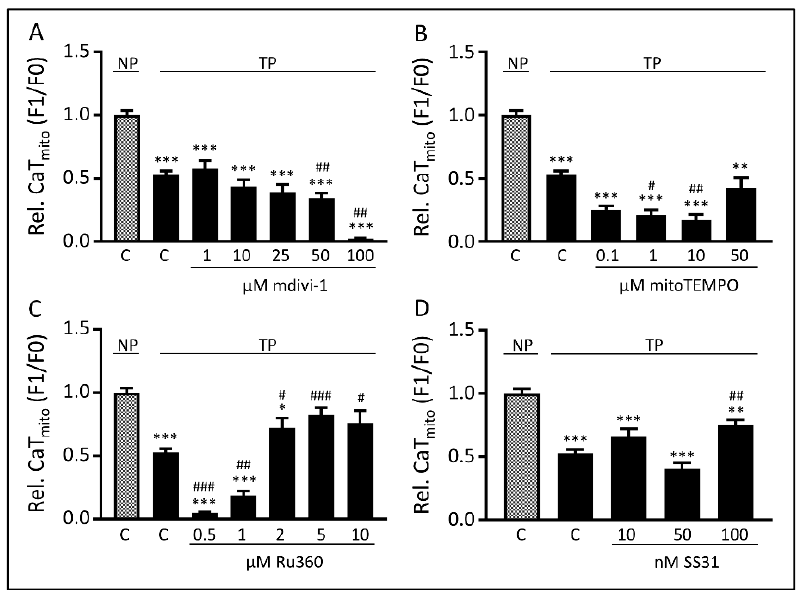
Figure 3. Ru360 and SS31, but not mdivi-1 or mitoTEMPO protect against tachypacing-induced CaT mito amplitude loss. CaT mito amplitude of normal-paced (NP) or 6h tachypaced (TP) with different concentrations of ( A ) mdivi-1, ( B ) mitoTEMPO, ( C ) Ru360 and ( D ) SS31. * p < 0.05, ** p < 0.01, *** p < 0.001 vs. NP C, # p < 0.05, ## p < 0.01, ### p < 0.001 vs. TP C.